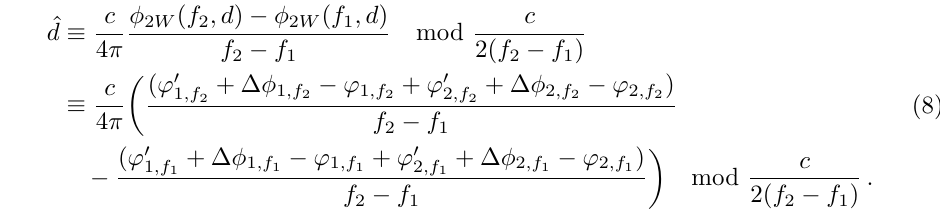
Figure 11: Phase manipulation attack on the